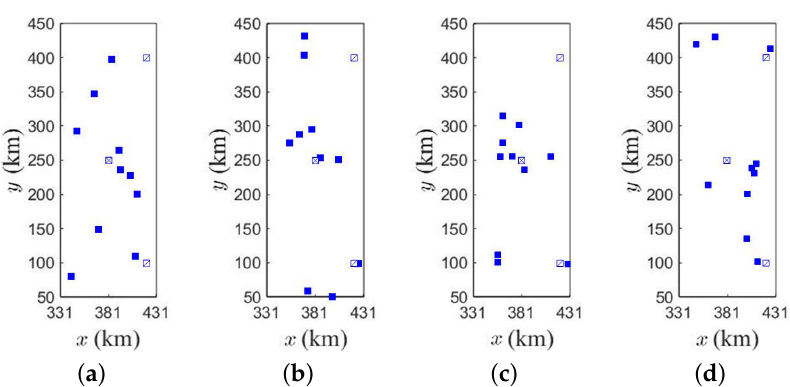
Figure 8. Optimal deployment of defense stations against slant formation, based on ( a ) ζ 1 ; ( b ) ζ 2 ; ( c ) ζ 3 ; ( d ) ζ 4 , square with cross: major post, square with slash: minor post, blue square: defense